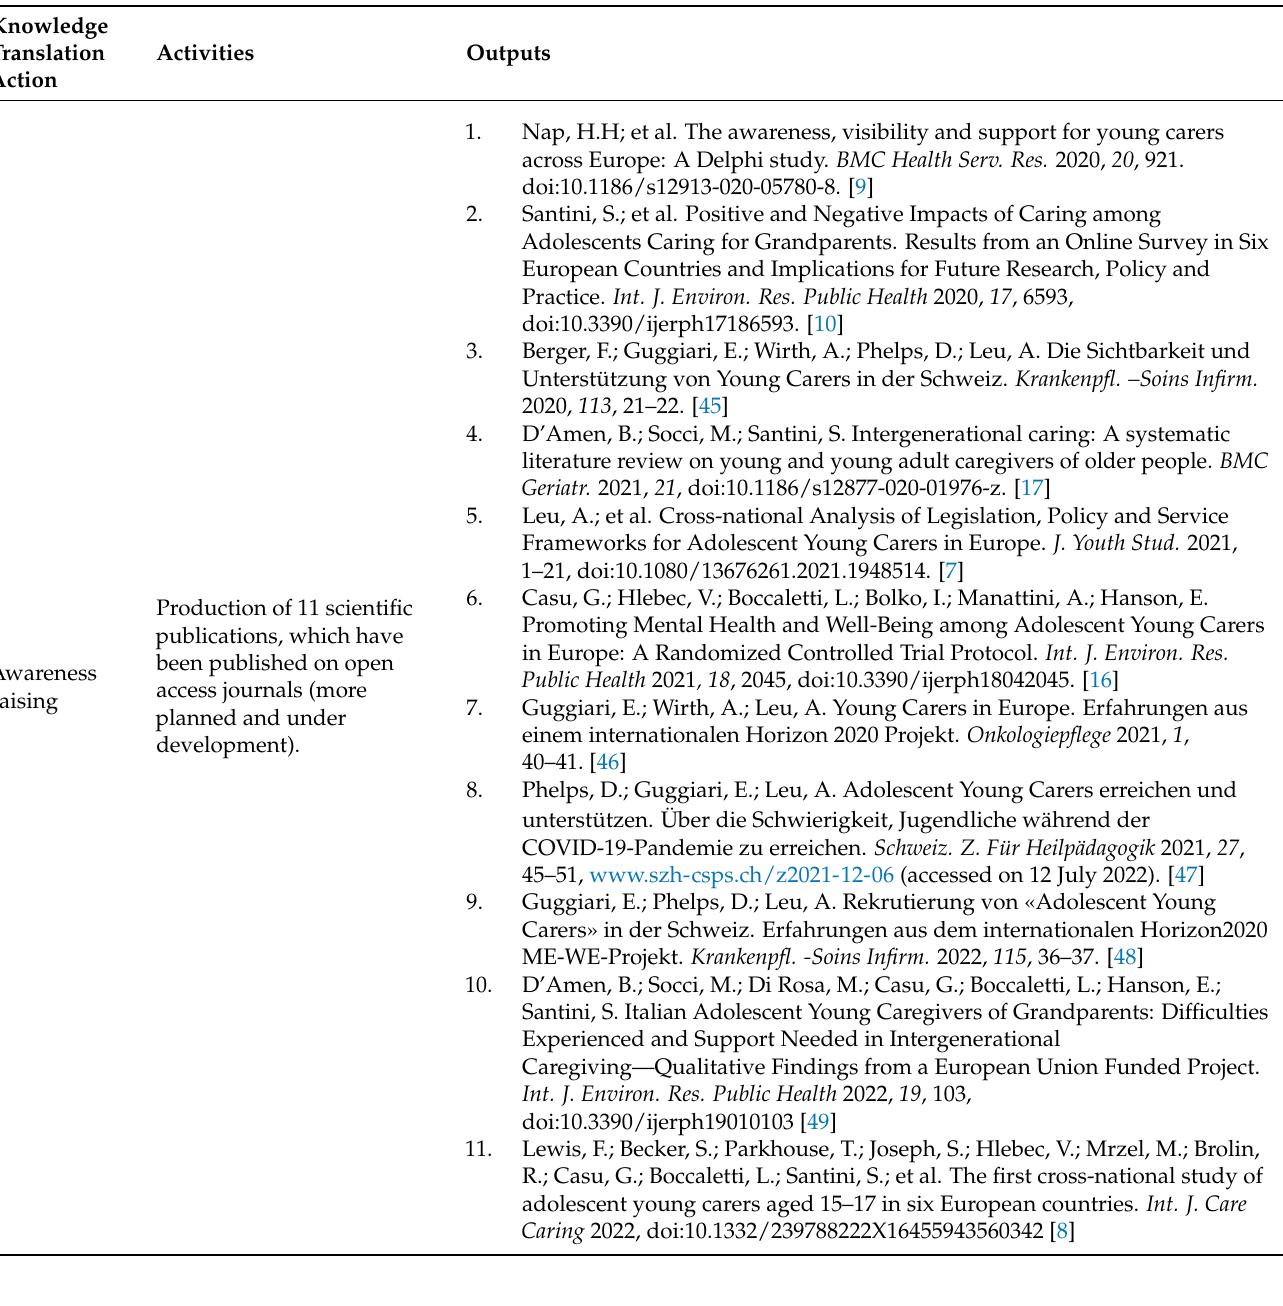
Table 10. Knowledge translation actions, activities and key outputs